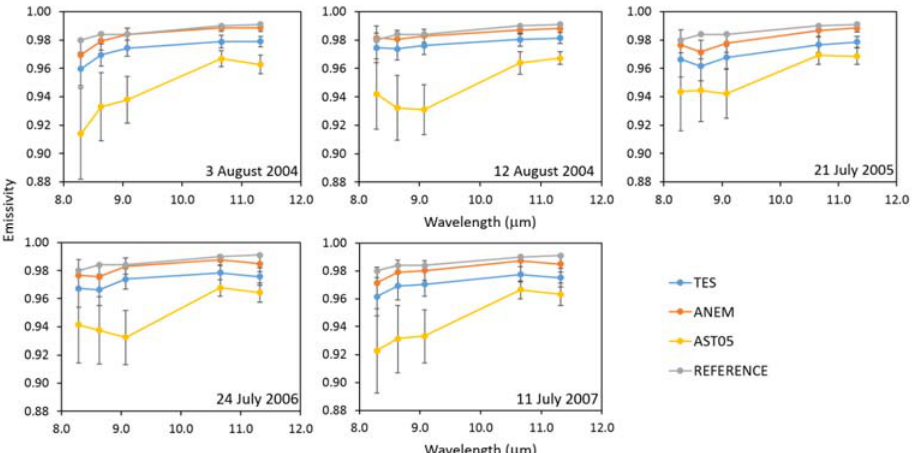
Figure 4. Water emissivity for each studied day provided by Niclòs et al. in [34] (REFERENCE), obtained with TES and ANEM methods and provided by the standard product AST05.